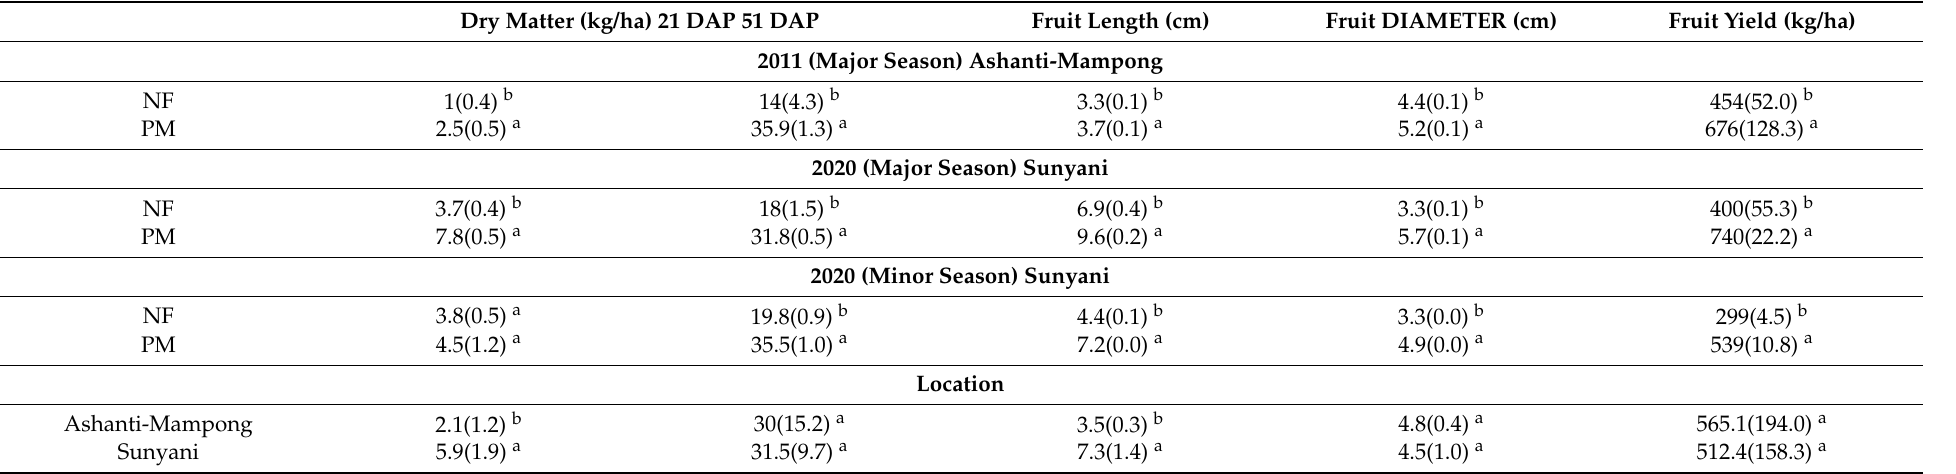
Table 4. Biomass and yield performance of garden eggs in a tropical sandy loam soil in Ghana under poultry manure